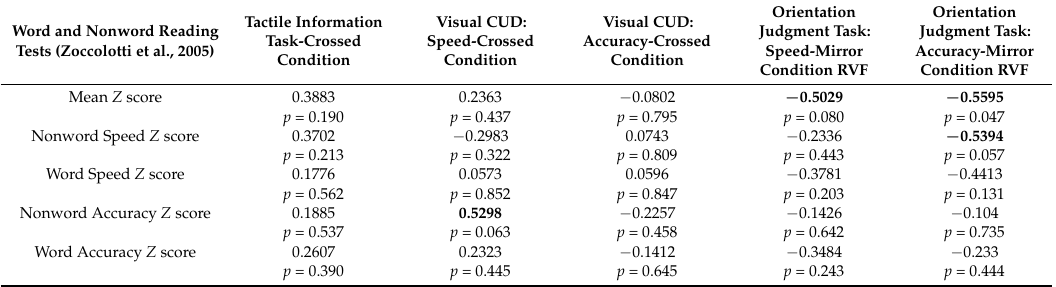
Table 2. Correlations between IHT measures (in columns) and reading indices (rows) in the group with DD (13 children). Correlation coefficients larger than 0.5 are highlighted in